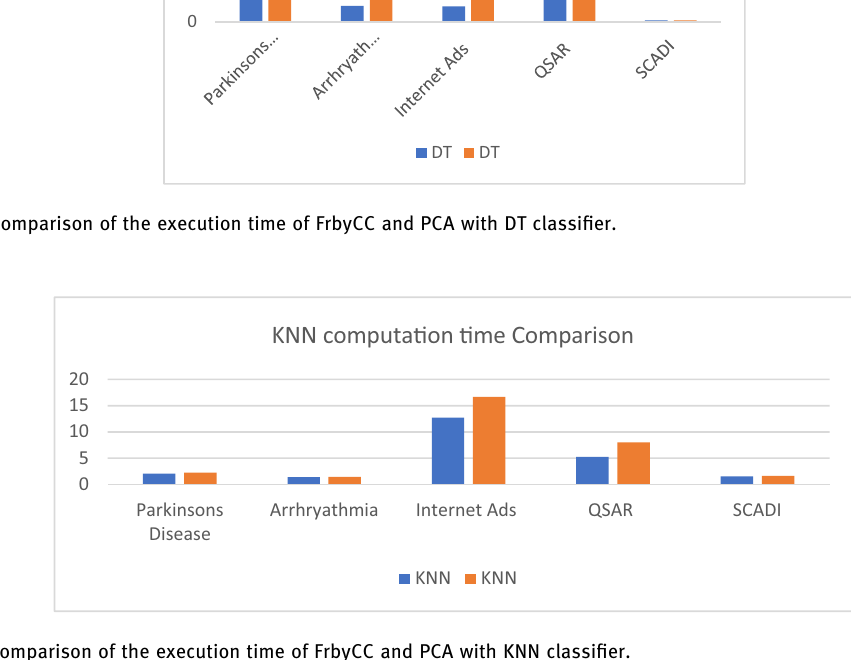
Figure 5: Comparison of the execution time of FrbyCC and PCA with KNN classi fi er.